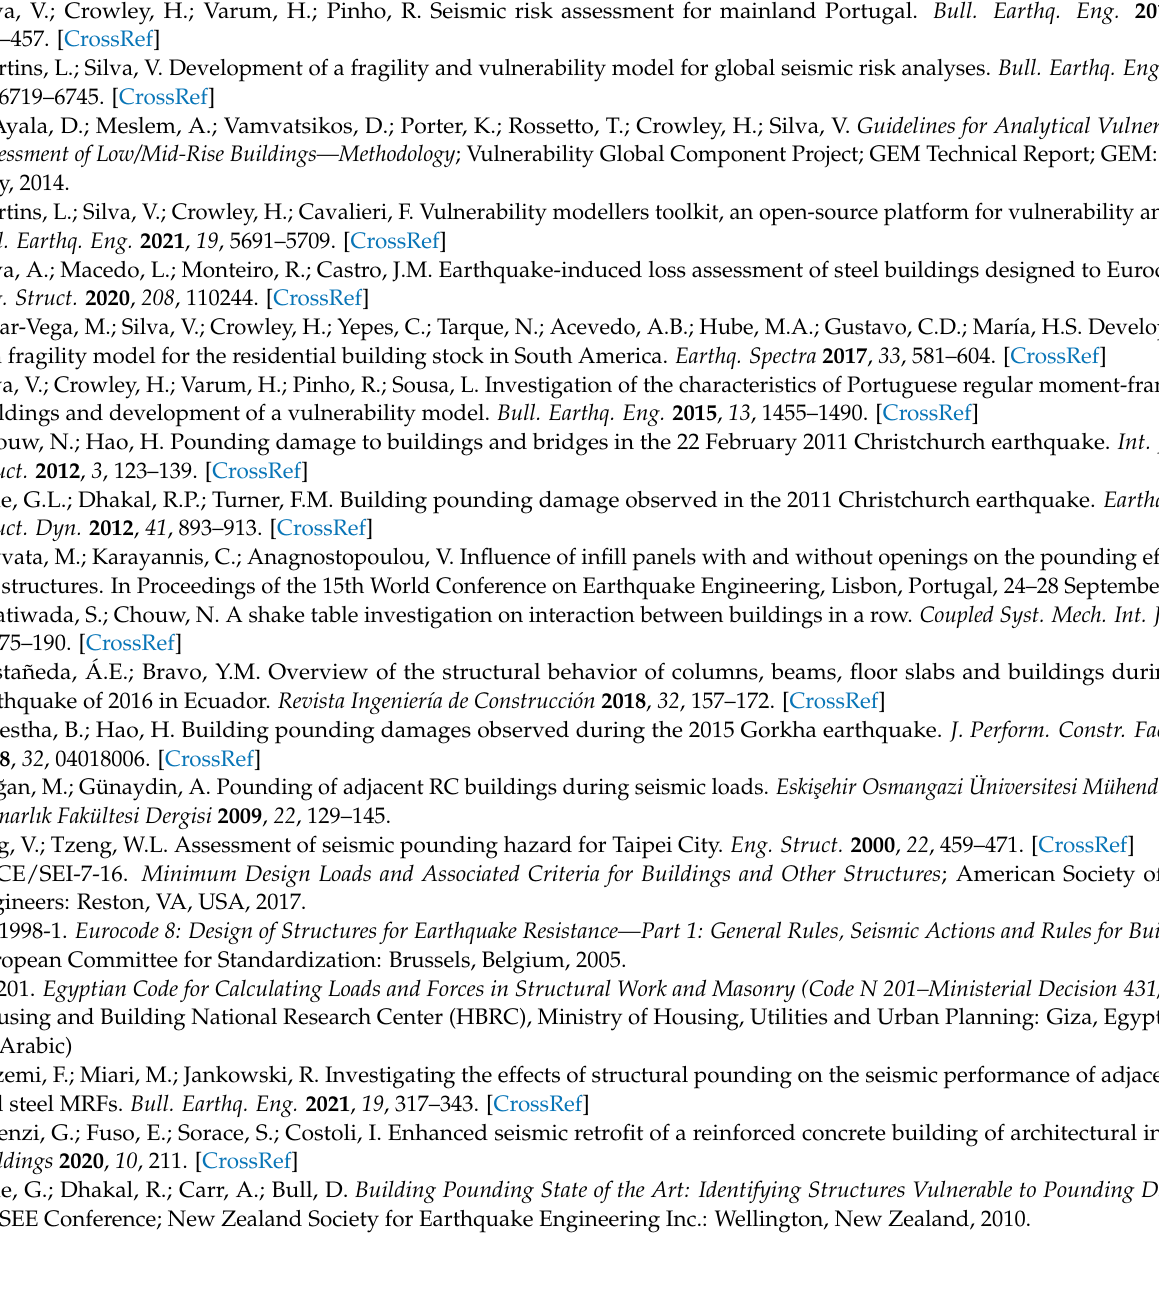
tions, Table S1: Characteristics of the selected ground